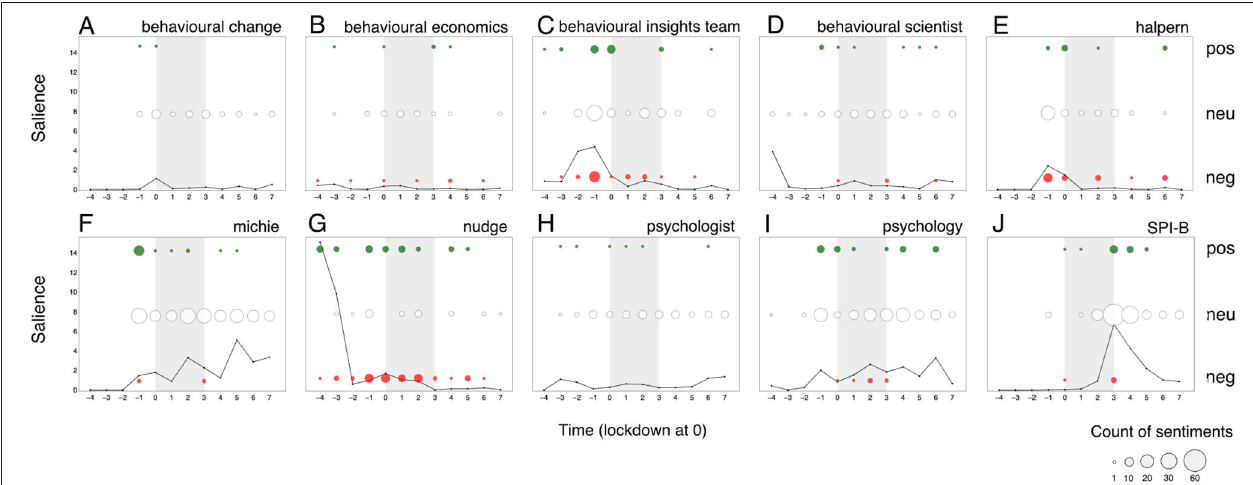
FIGURE 3 | Salience of and sentiment toward the 10 primary keywords over the 12 two-week time period surrounding the first British national lockdown of 2020 (gray area) in print media (top 15 UK newspapers). (A) behaviour change (concept), (B) behavioural economics (discipline), (C) behavioural Insights Team (named actor), (D) behavioural scientist (unnamed actor), (E) halpern (named actor), (F) michie (named actor), (G) nudge (concept), (H) psychologist (unnamed actor), (I) psychology (discipline), (J) SPI-B (names actor). Salience is calculated per 2-week period as the normalized term frequency (per 10,000 words) multiplied by the proportion of articles that mention the keyword. Sentiments are represented in counts of positive ( + 1 or + 2), neutral (0), and negative ( − 2 or − 1) bubbles over time, in green, white and red respectively. The area of the bubbles is proportional to the count of sentiments toward the keyword.